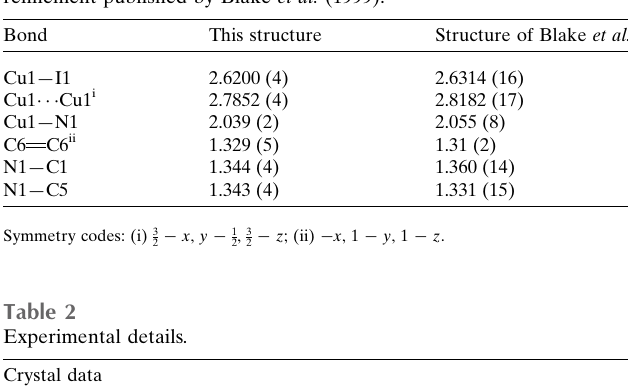
Table 1 Comparison of some bond lengths (A˚ ) in the reported refinement and the refinement published by Blake et al.